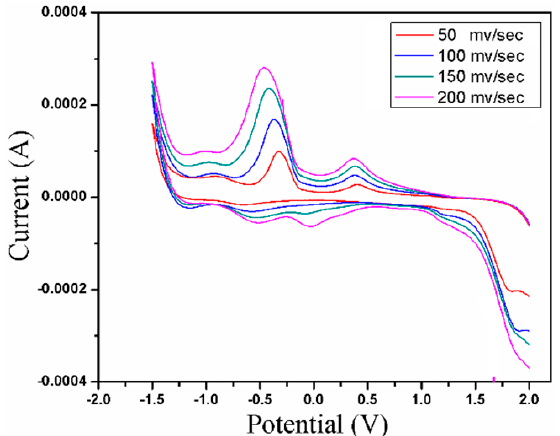
Figure 3. Cyclic voltammograms of compound 1 plotted at scan rates of 50, 100, 150 and 200 mV s − 1